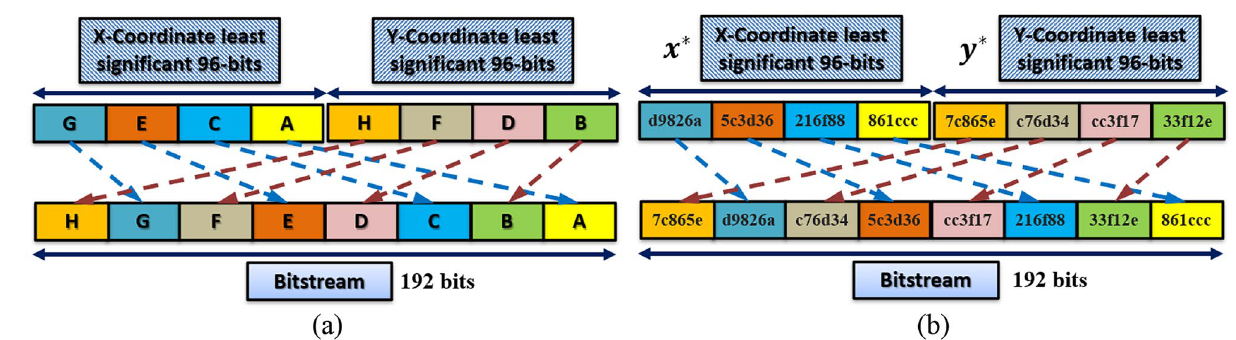
Figure 5. ( a ) Conversion from a point on EC to bitstream representation and ( b ) an